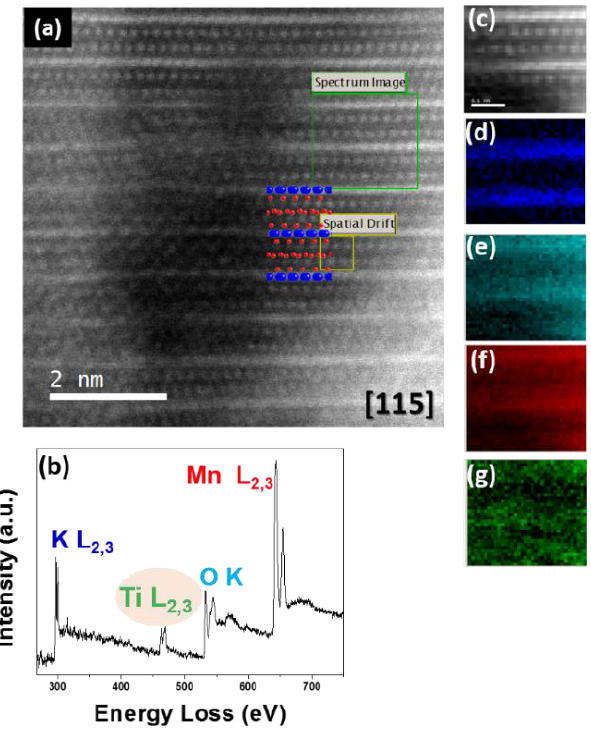
Figure 11. ( a ) STEM-HAADF image corresponding to K 0.11 Mn 0.92 Ti 0.08 O 2 ; ( b ) sum spectra of the area framed in green in ( a ); ( c ) simultaneously acquired HAADF image; ( d ) K-L 2,3 chemical map; ( e ) O-K chemical map; ( f ) Mn-L 2,3 chemical map and ( g ) Ti-L 2,3 chemical map.